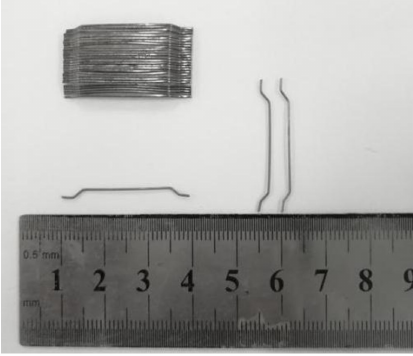
Figure 2. Type and size of steel fiber.